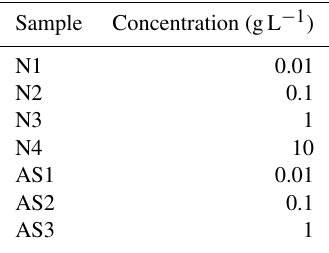
Table 1. Designations of the aqueous solutions of nigrosin (N1–N4) and ammonium sulfate which were